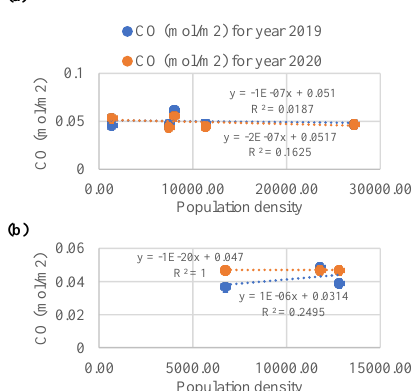
Figure 15. Influence of population density on CO